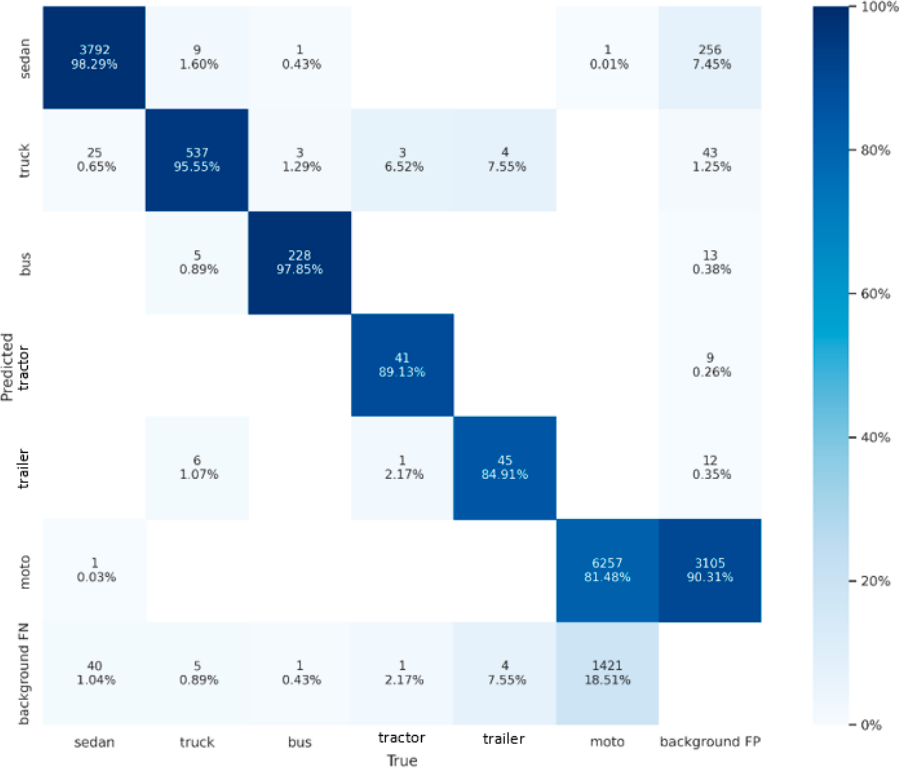
Figure 4. Confusion matrix of our dataset. The horizontal axis is the ground truth and the vertical axis is the predicted result. Confidence threshold and IoU threshold are set to 0.01 and 0.1, respectively. Figures 5–7 show some detection results on DOTA1.0, HRSC2016 and our dataset. The color of its OBB indicated the class of each detected object, and the white side denotes the front side of the object. As we can see, our model has outstanding detection results under various scales of aerial scenarios.